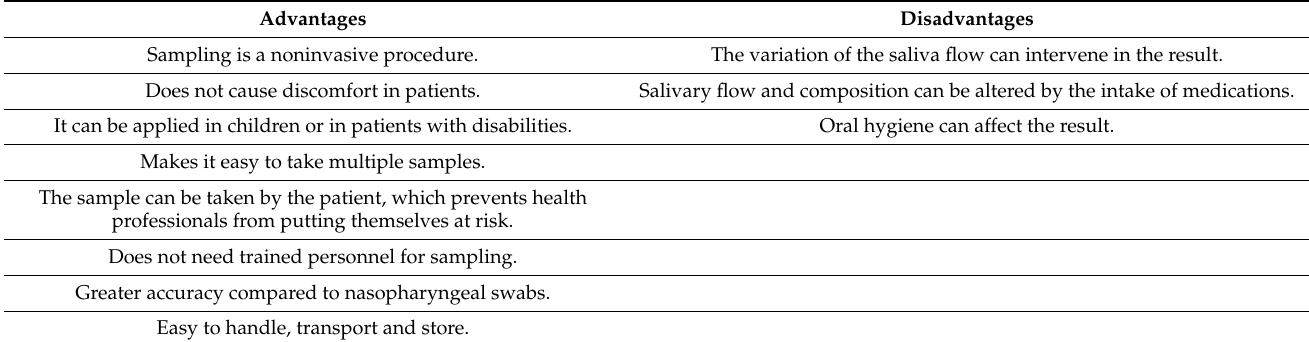
Table 2. Advantages and disadvantages of salivary sampling for the diagnosis of SARS-CoV-2.